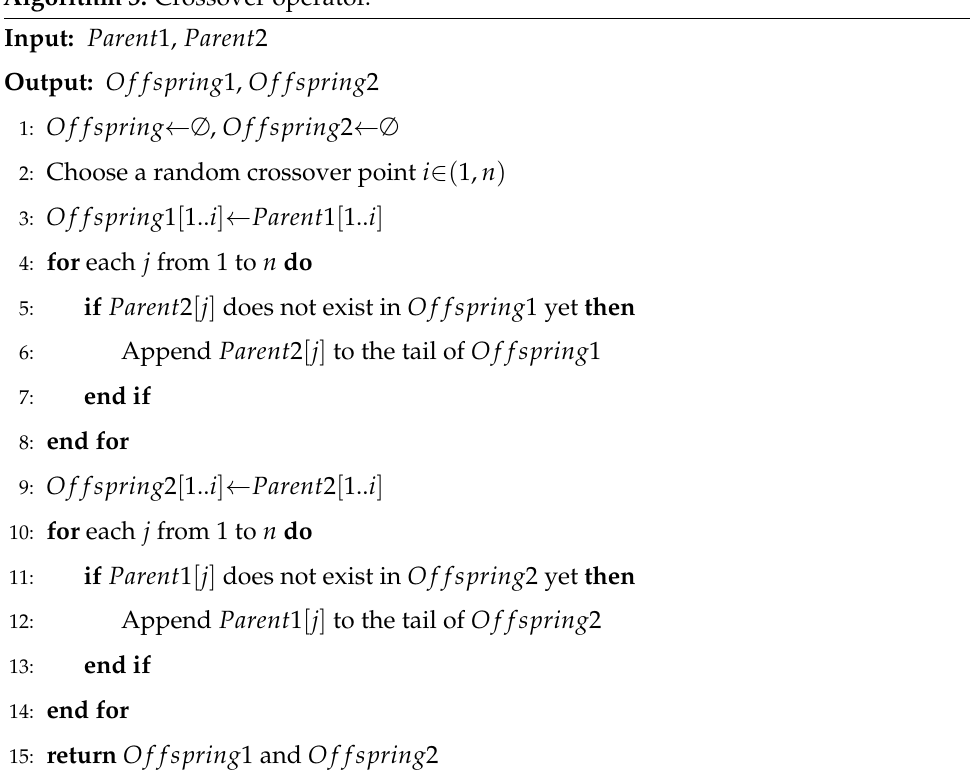
Algorithm 3. Crossover operator.